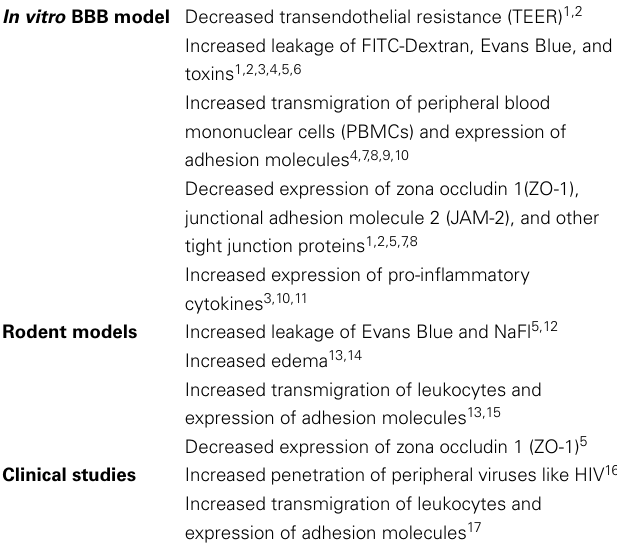
Table 3 | Summary of the preclinical and clinical literature on cocaine-induced BBB